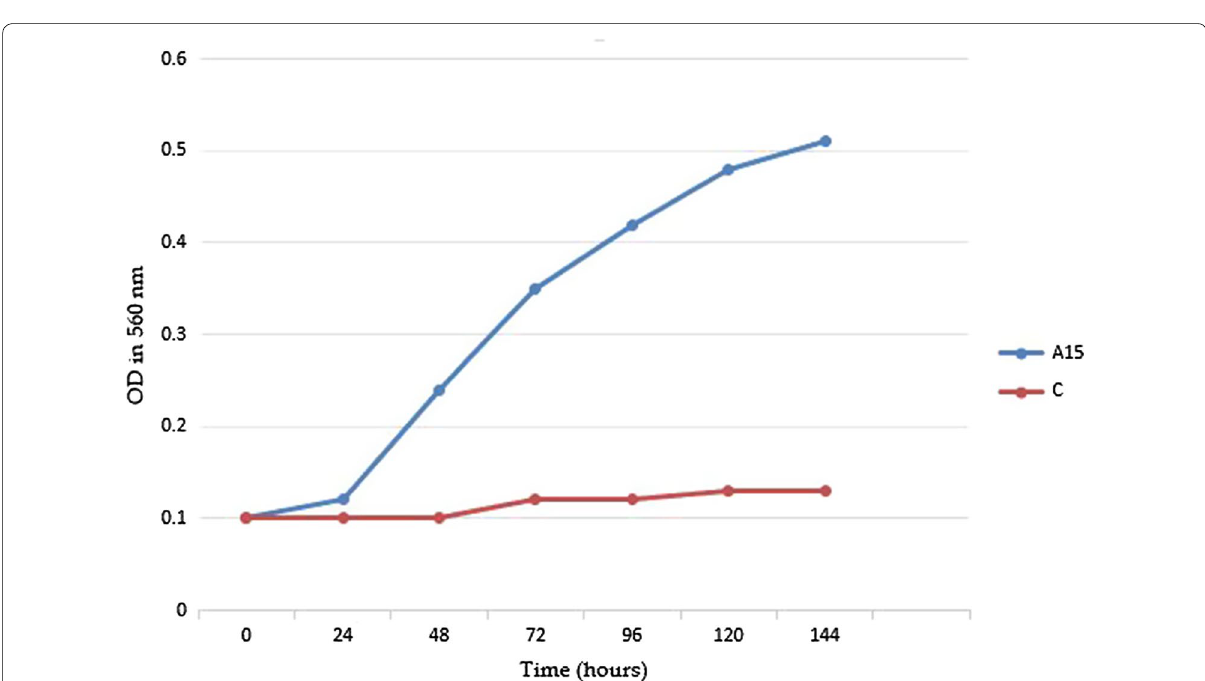
Fig. 5 Growth curves of Iranian mycobacterium isolates over a 24 h. Incubation period at 30 °C in the presence of